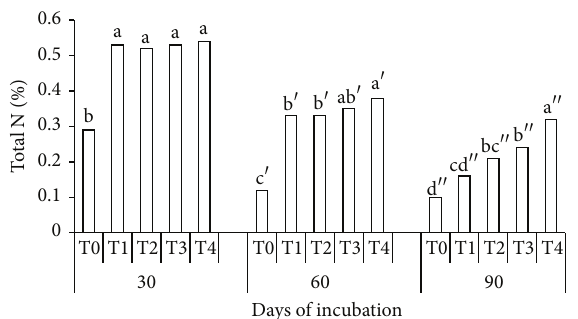
Figure 2: Effects of treatments (T0, T1, T2, T3, and T4) and periods (30, 60, and 90 days) of incubation on soil pH. Note . T0: 250 g soil (no urea); T1: 250 g soil + 7.40 g urea (no additives); T2: 250 g soil + 7.40 g urea + 6 g clinoptilolite zeolite; T3: 250 g soil + 7.40 g urea + 6